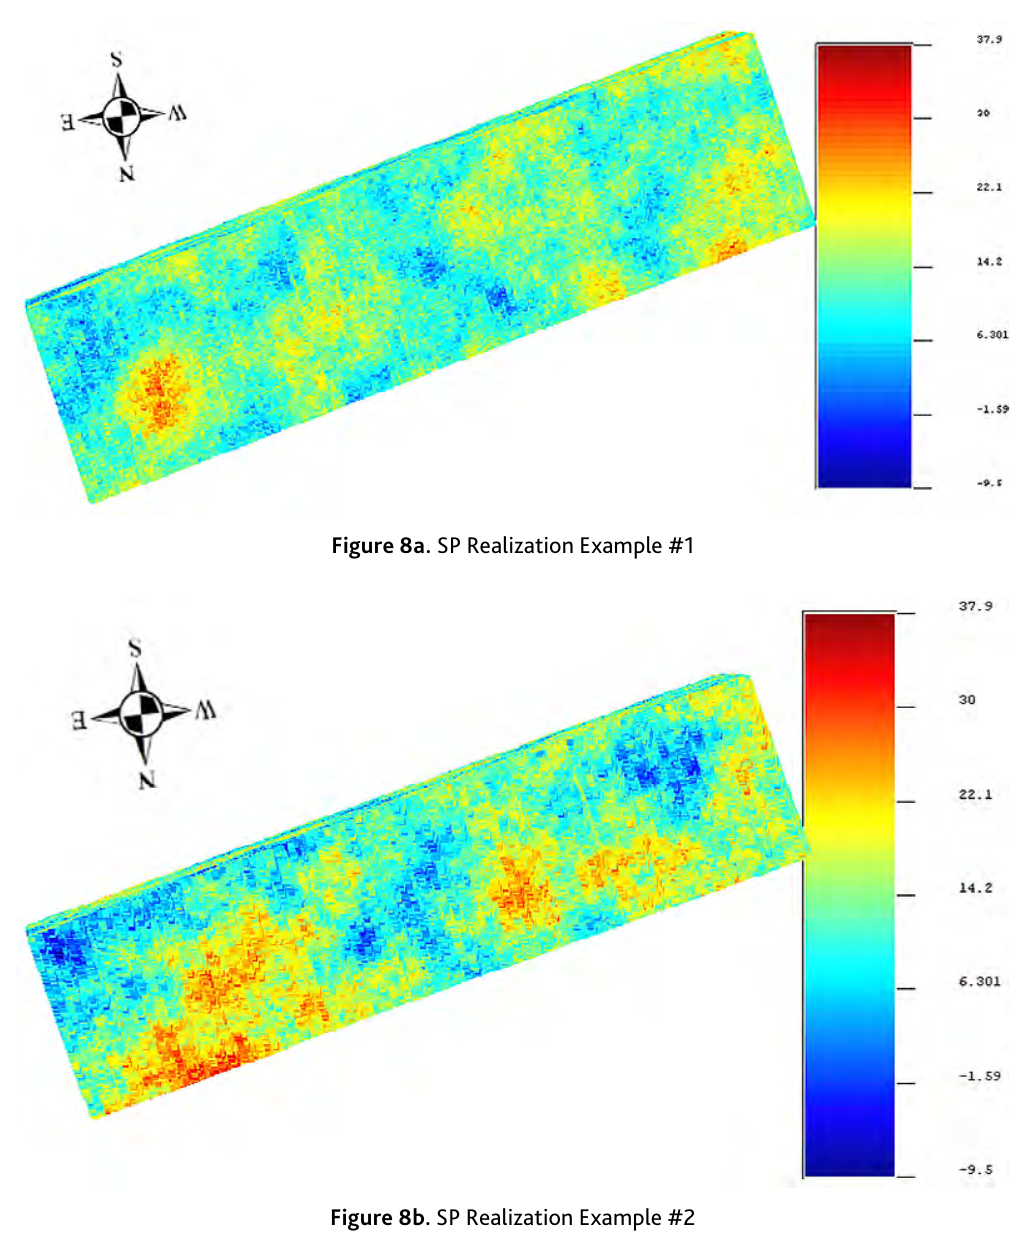
Figure 8b. SP Realization Example